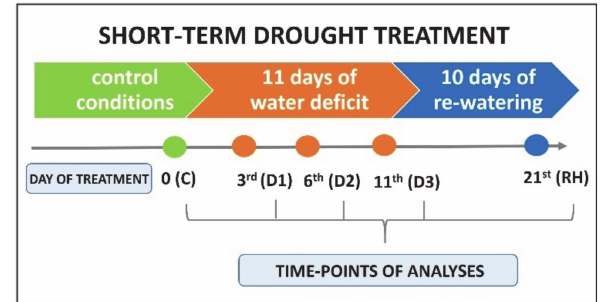
Figure 7. The scheme of short-term drought experiment performed with F. arundinacea and F. glaucescens